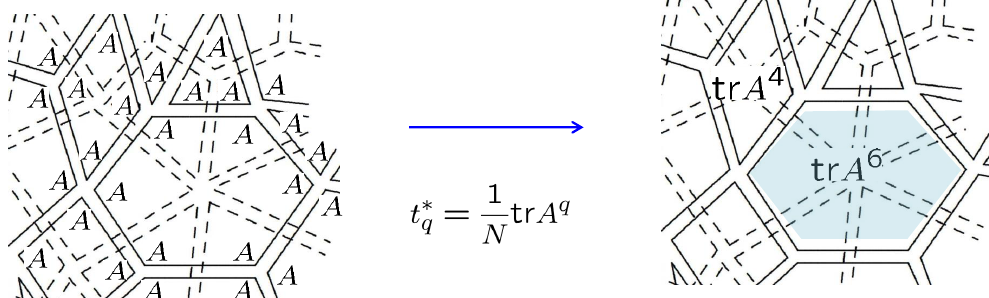
Figure 1 . A dually weighted Feynman graph. Solid double lines show the propagators, while the dashed lines show the dual graph (whose vertices correspond to faces of the original graph and vice versa). At each n -vertex we have n copies of the matrix A which after contraction give factors ∝ tr A q corresponding to each q